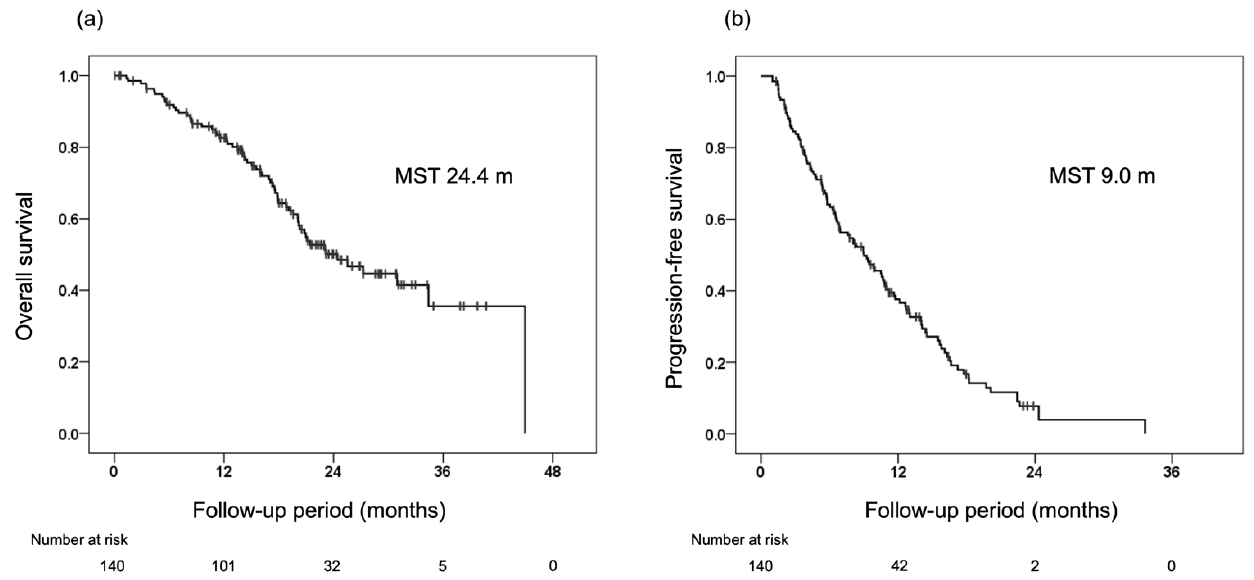
Figure 1. Overall survival (OS) and progression-free survival (PFS) from the initiation of lenvatinib in the 140 patients included in this study. ( a ) OS from the initiation of lenvatinib (median survival time, 24.4 months). ( b ) PFS from the initiation of lenvatinib (median survival time, 9.0 months). Table 2. Radiological response to lenvatinib.